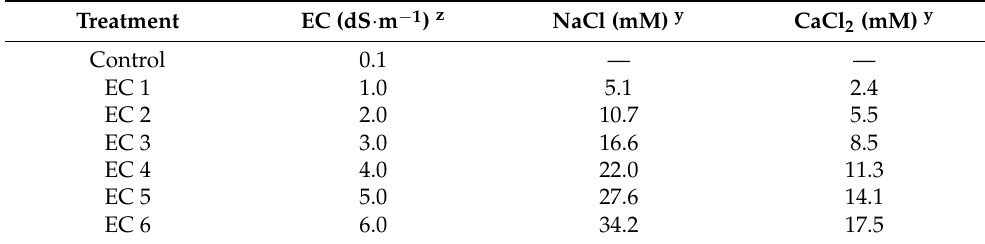
Table 1. The electrical conductivity (EC) and composition of control and salt solutions used in the study. Treatment